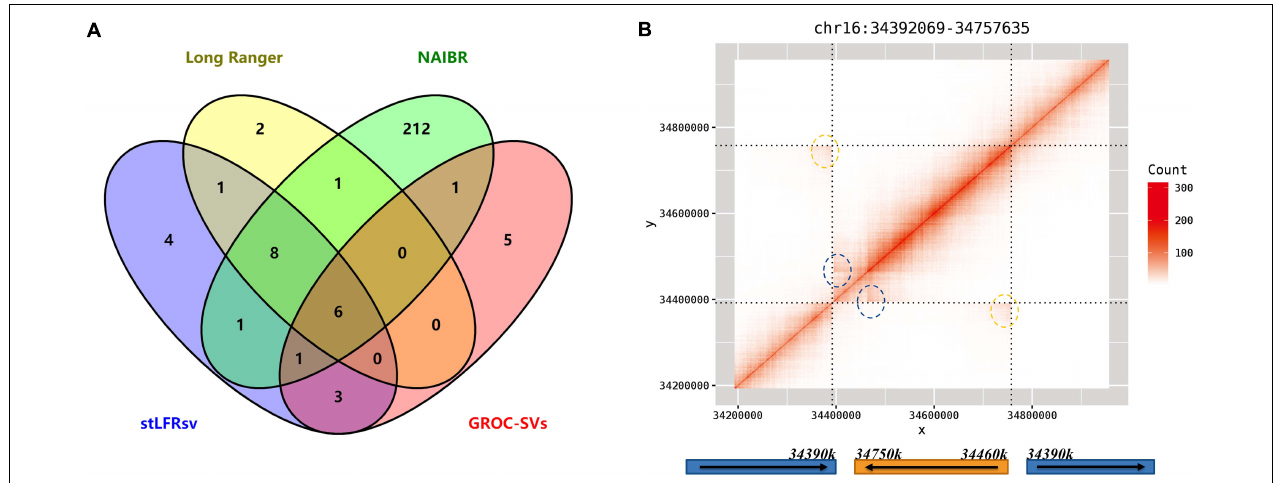
FIGURE 5 | (A) Venn diagram of detected deletions from four structural variant (SV) callers in HG001. (B) The heatmap and structure for a complex inversion in HG001. The signs of two breakpoints are marked by blue and yellow circles in the heatmap.